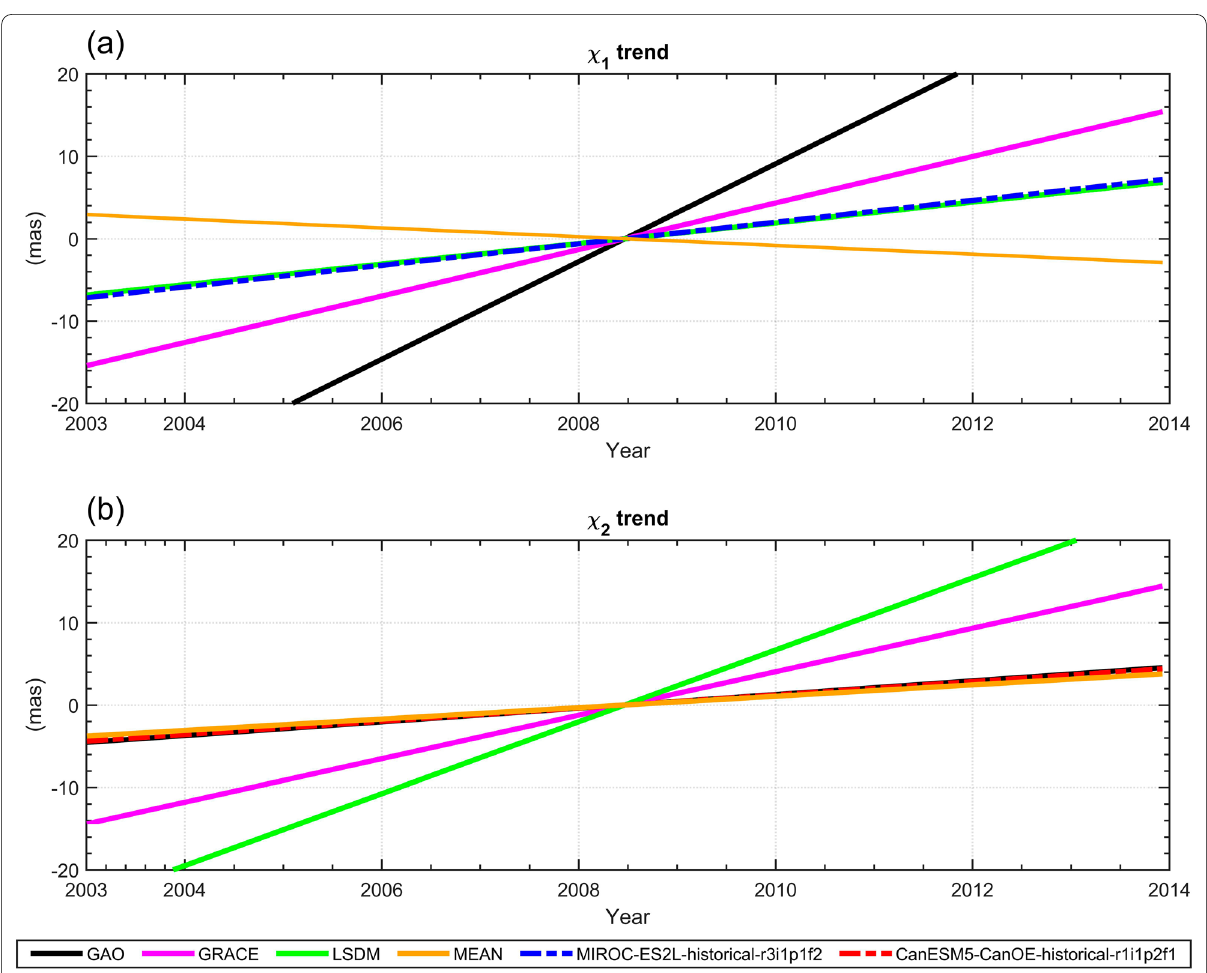
Fig. 3 The CMIP6 models best suited to GAO in terms of the trends (blue line for χ 1 in a and red line for χ 2 in b ). The results obtained from GRACE, LSDM and MEAN model are also